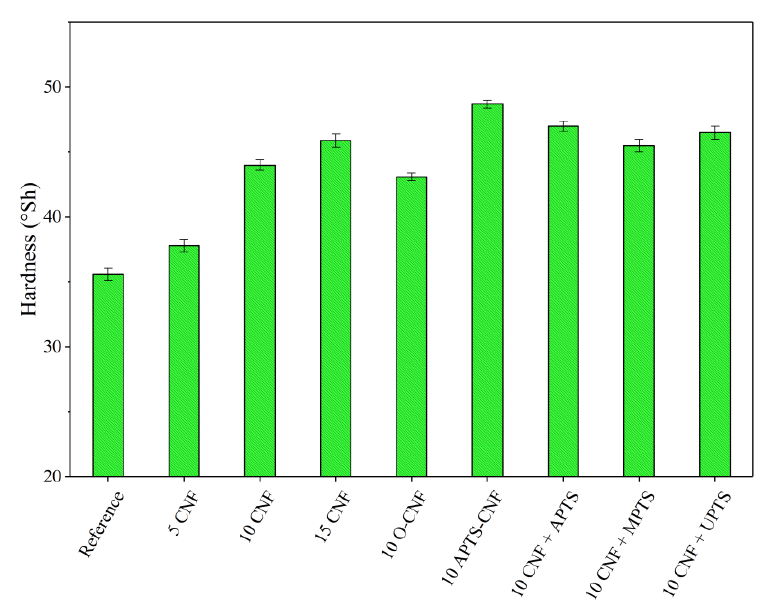
Figure 11. Hardness parameters obtained for NBR composites with modified carbon nanofibers. Materials 2020 , 13 , x FOR PEER REVIEW